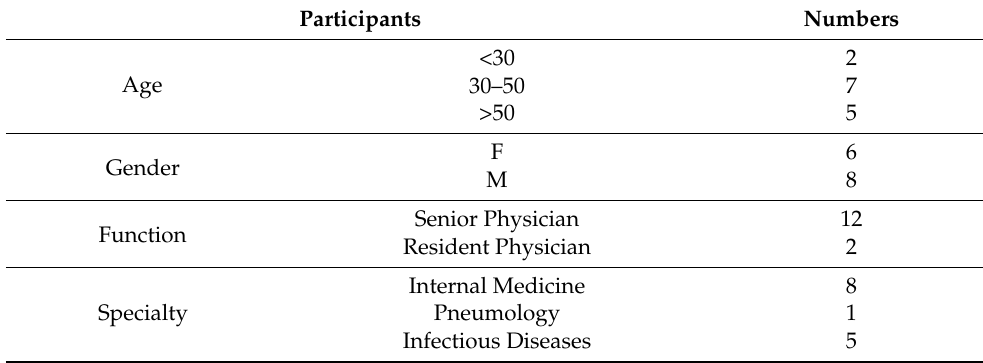
Table 4. Participants’ characteristics.